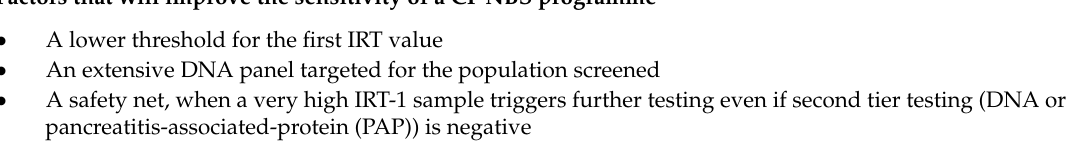
Table 1. Factors to consider when designing a protocol for cystic fibrosis (CF) newborn bloodspot screening